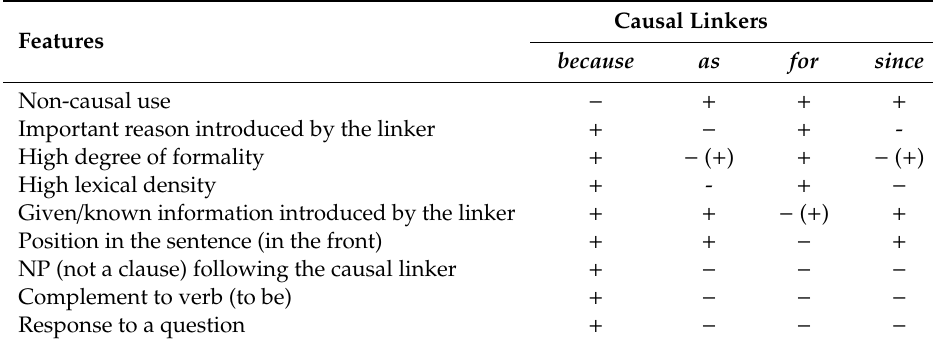
Table 1. Features determining the use of because , as , for and since